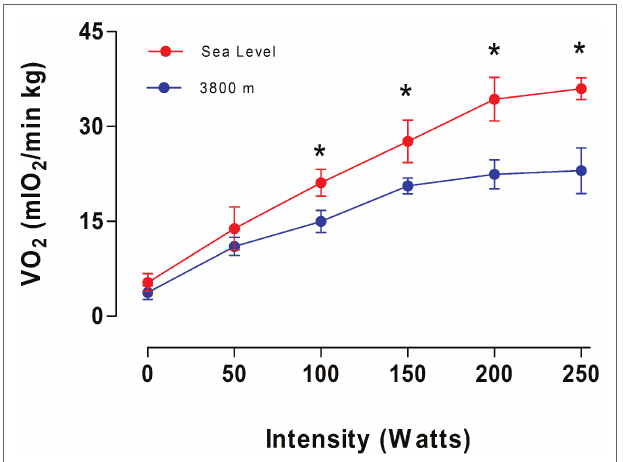
FIGURE 3 | (A,B) show average values of calculated Net efficiency and Gross efficiency as a function of intensity (in W/kg) obtained on the fourth day at Sea level and 3,800 m. * represents a significant difference between Sea level vs. High altitude ( p <